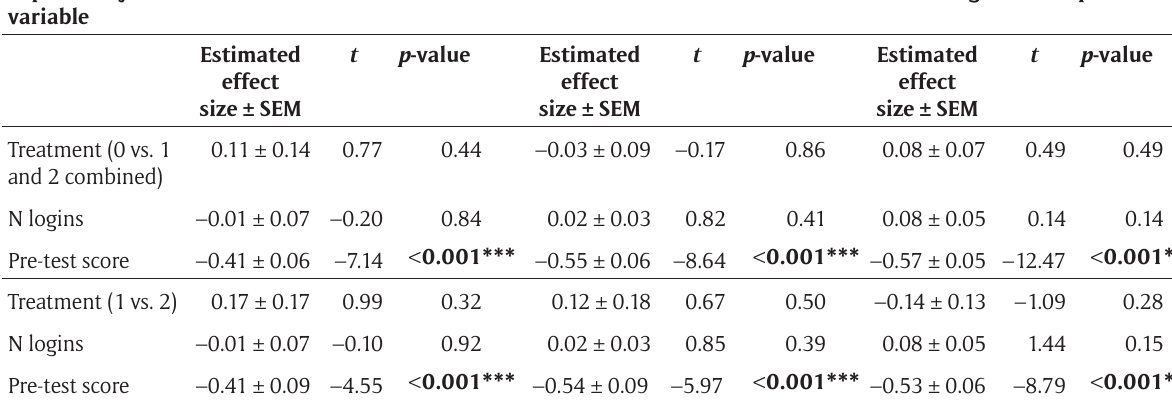
Table 6: Results of General Linear Models to test predictions regarding learning as measured by post-pre differences. The response variable was post-pre difference in scores for Bird-ID, Tree-ID, and Ecological concepts (analyzed sepa- rately). The explanatory variables included experimental treatment (waitlist control was coded as zero; the non-social treatment was coded as 1; and the social treatment was coded as 2), number of logins as a measure of a participant’s activity in the project, and pre-test score (birds, trees, or ecological concepts). The r-square for these analyses ranged from